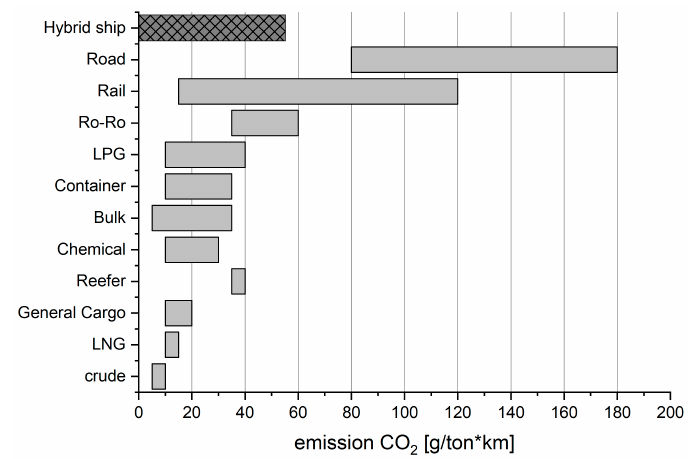
Figure 1. Comparison of different transport modes concerning the CO 2 emission per tonne-km of cargo [2]; analysed case of an inland ship with hybrid propulsion and solar modules was added.